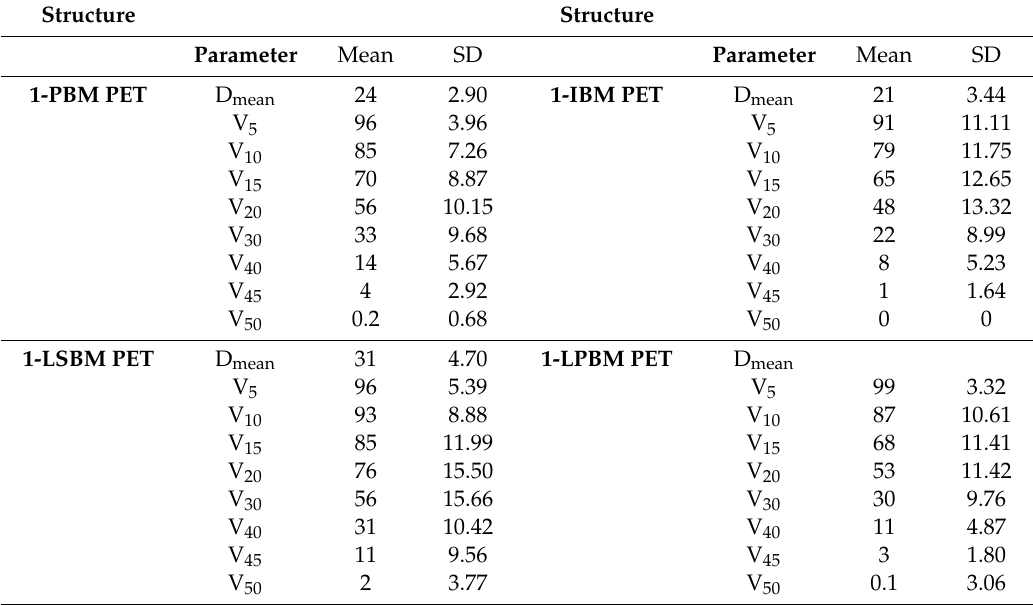
Table A2. Dosimetric parameters of inactive bone marrow as outlined on positron emission tomography.